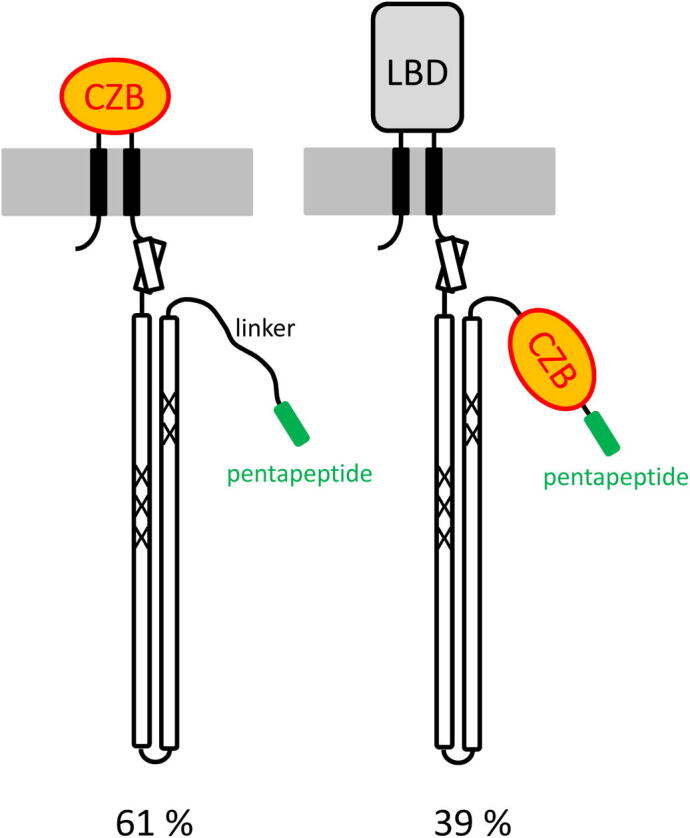
Schematic representation of chemoreceptors that contain a pentapeptide fused to the signaling domain or the CZB zinc binding domain. The individual proteins are listed in Supp. Table 3.